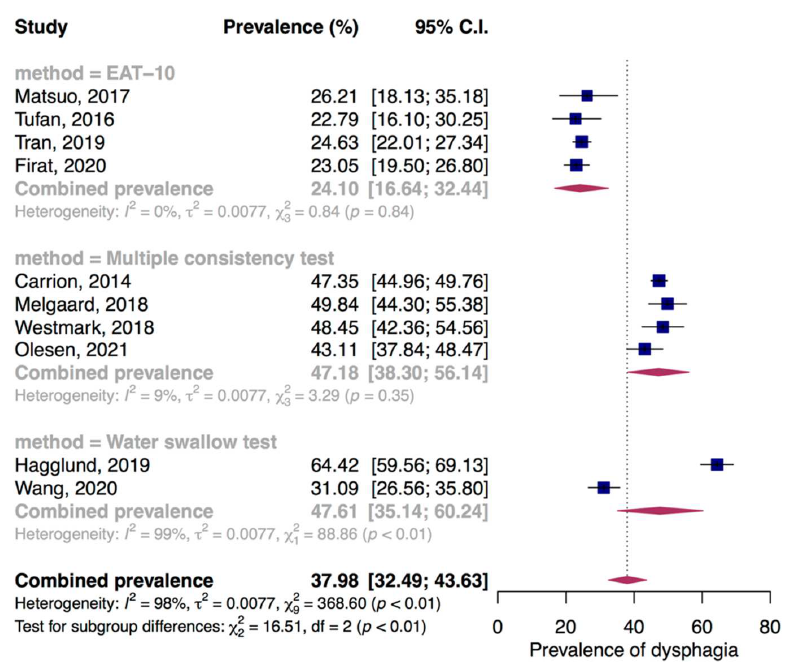
Figure 4. Prevalence of dysphagia in hospitalized older adults. EAT-10, 10-item Eating Assessment Tool; multiple consistency test, volume-viscosity swallow test or Gugging Swallowing Screen test.